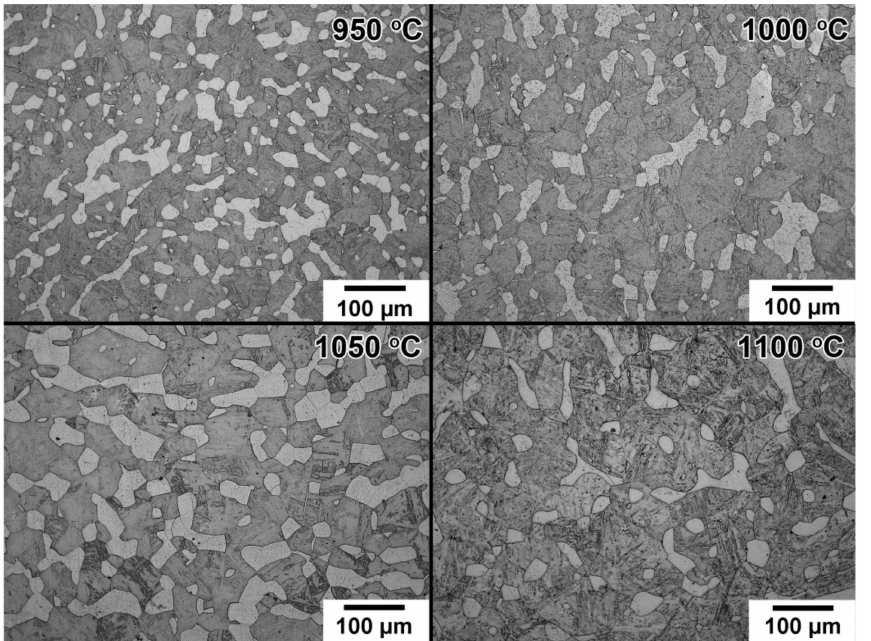
Figure 6. Optical metallography of the 12% Cr steel homogenized and forged at 1200 ◦ C after an additional long-term annealing at 950 ◦ C, 1000 ◦ C, 1050 ◦ C, and 1100 ◦ C for 88 h, air